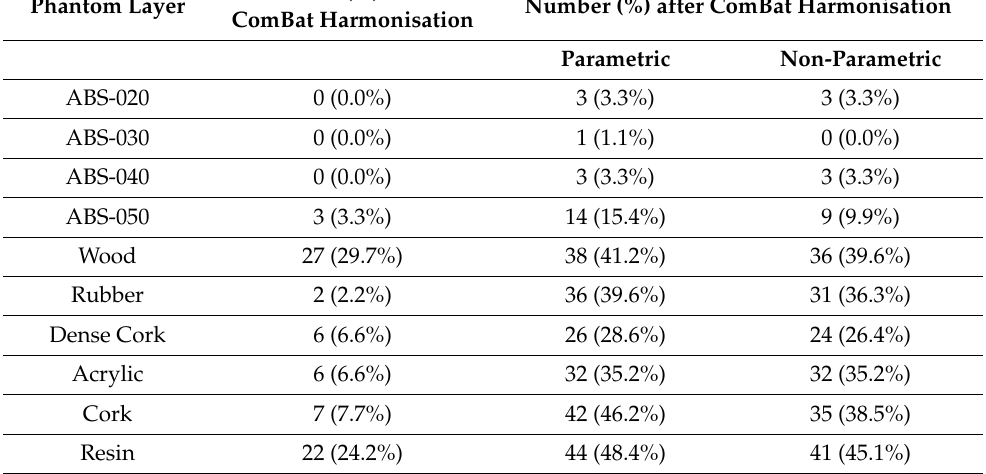
Table 1. The number of reproducible radiomic features for the different phantom layers between scan CCR-2-001 and